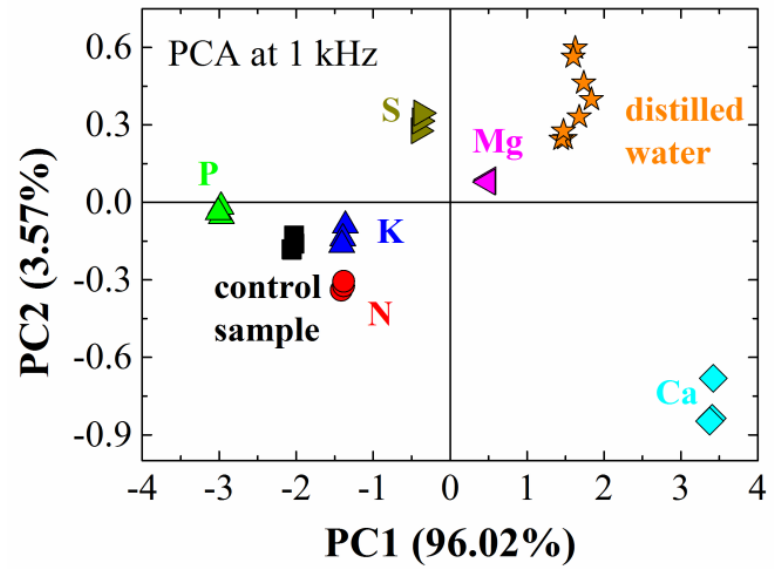
Figure 6. Principal component analysis (PCA) of the microfluidic e-tongue applied to liquid aliquots of soil samples (control, N, P, K, Ca, Mg, and S) under flow conditions.